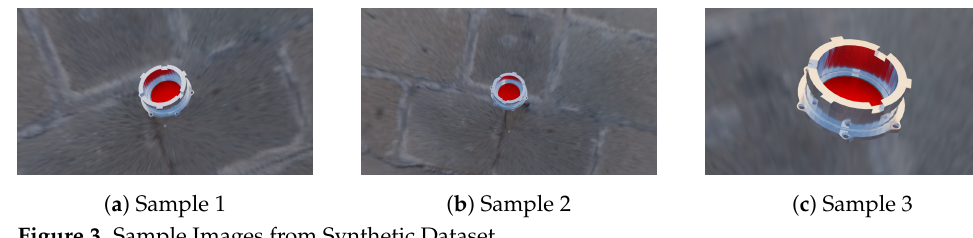
Figure 3. Sample Images from Synthetic